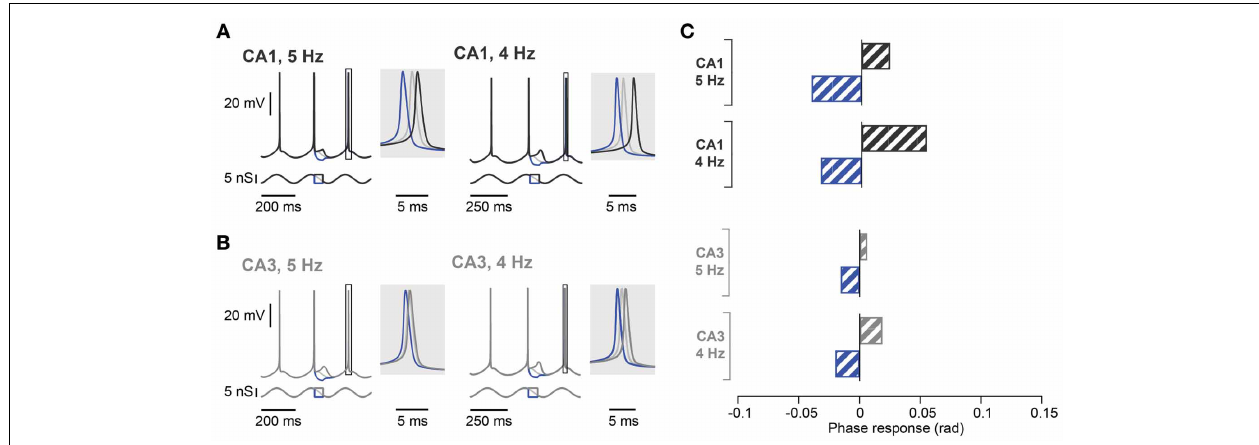
FIGURE 6 | Spike phase control in computational models of hippocampal CA1 and CA3 pyramidal neurons. (A) Voltage response of CA1 neuron model (top traces) in response to excitatory and inhibitory perturbation of an oscillatory input (bottom traces) at 5Hz (left panel) or 4Hz (right panel). The voltage response around the control spike is expanded to display spike phase responses. The